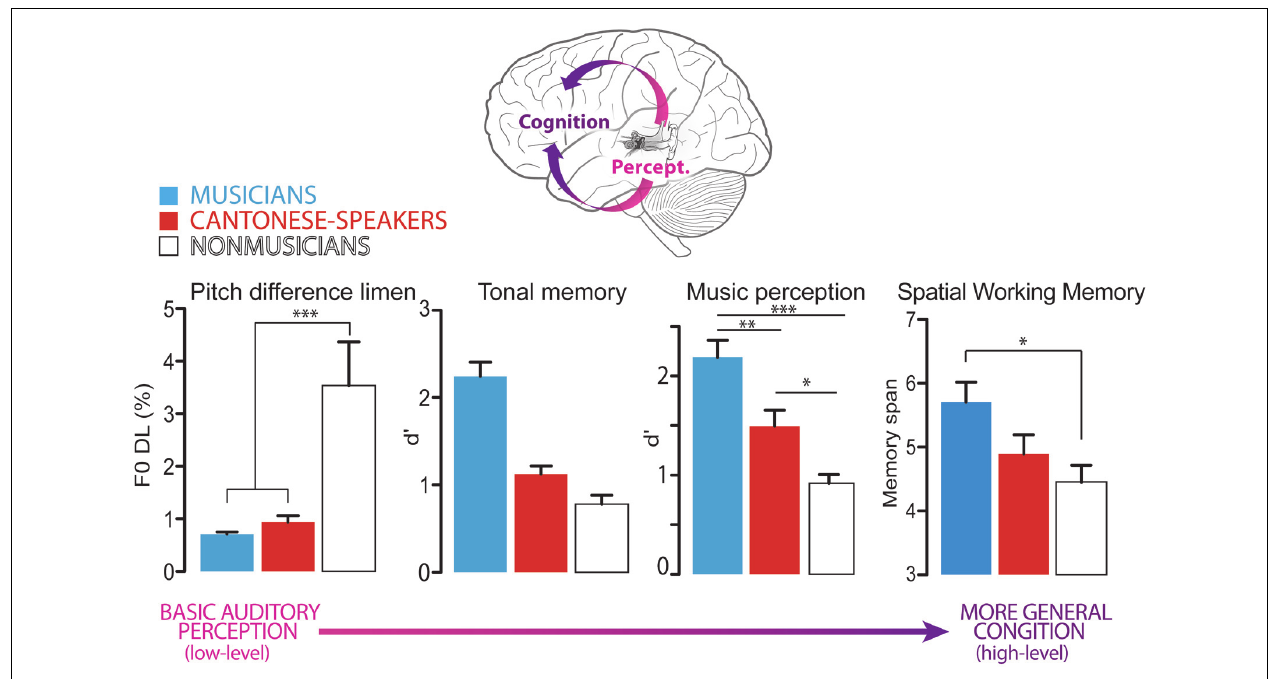
FIGURE 1 | Figure adapted from Bidelman etal. (2013), illustrating language-to-music transfer. Enhanced perceptual and cognitive mechanisms operating in a processing hierarchy (from low-level auditory perception to more general cognition) may explain the behavioral and neural advantages observed in musicians versus tone –language bilinguals. Specifically, musicians and tone-language bilinguals show